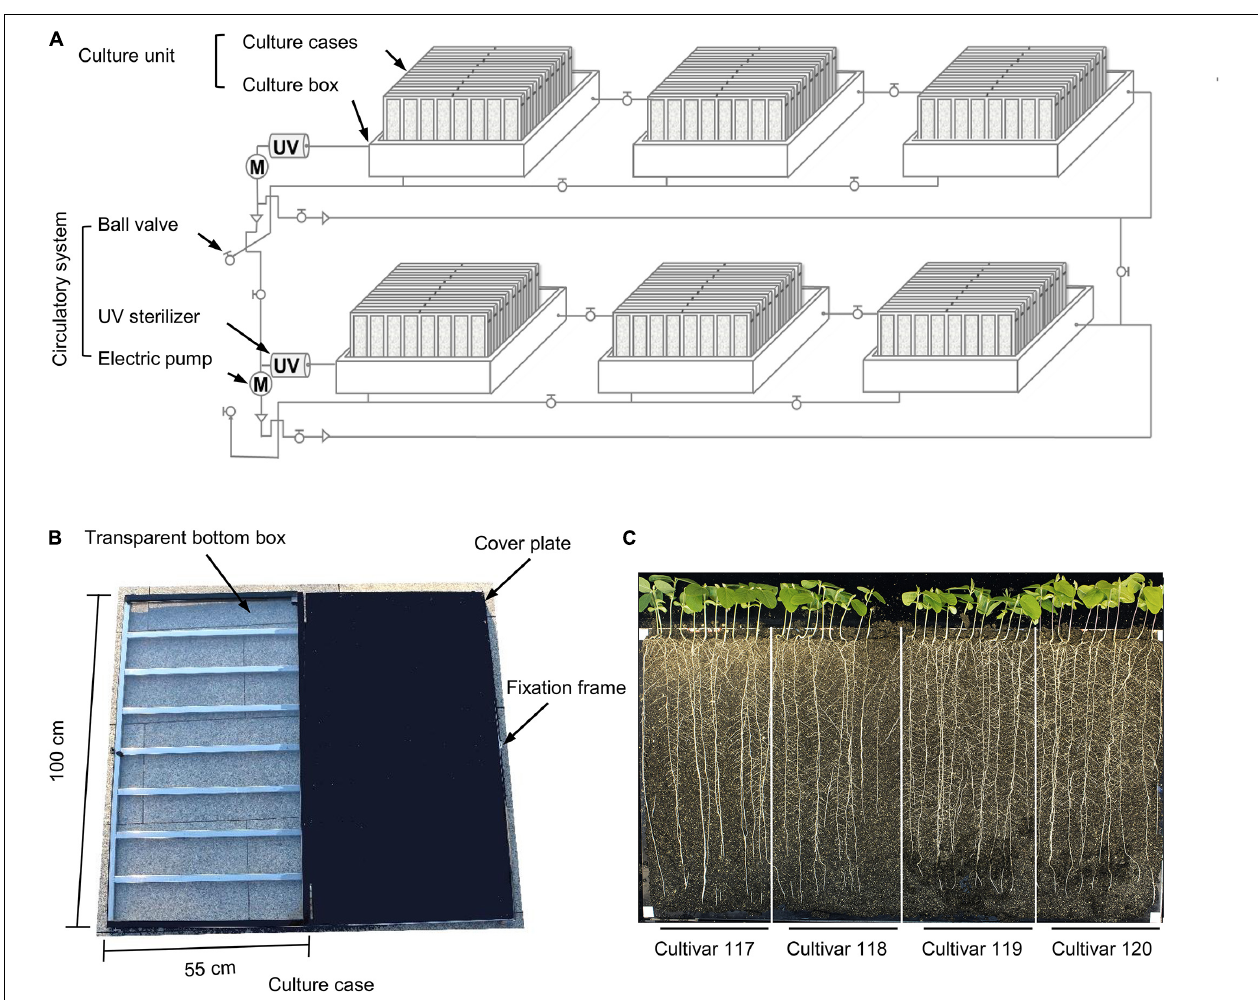
FIGURE 2 | Individual components of the WinRoots system. (A) Schematic diagram of all components of the WinRoots system. (B) Structure of a single culture case. (C) Representative images of whole seedlings from four soybean cultivars grown in the same culture case for 10 days. Bar, 5 cm.